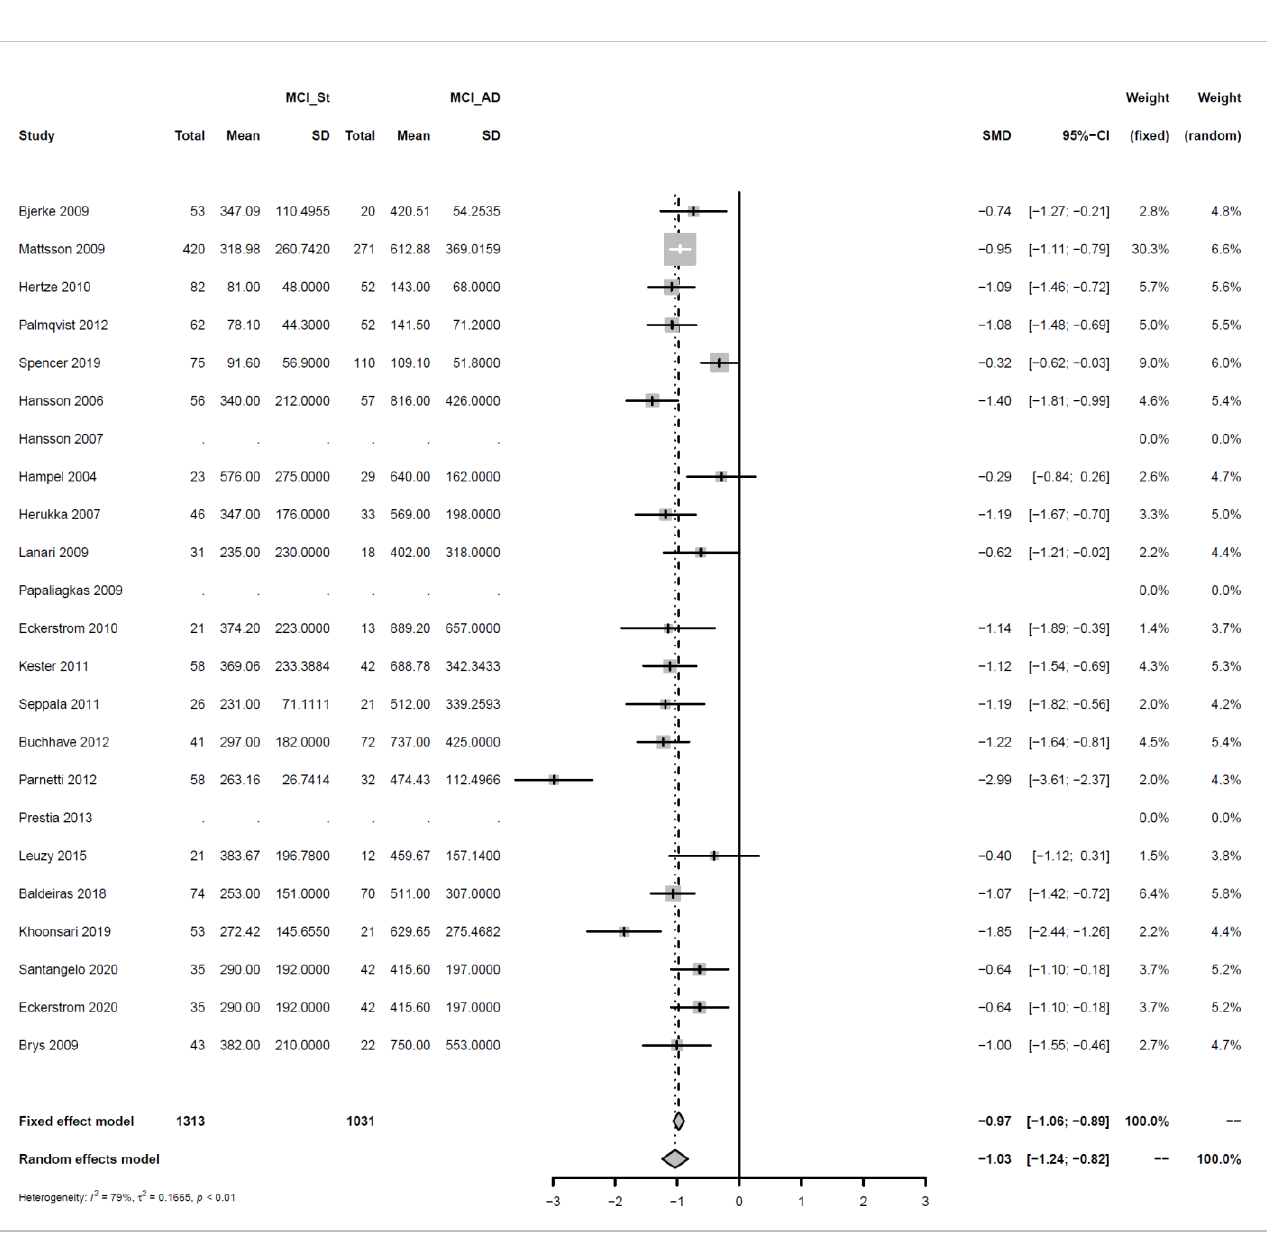
Figure 9. Meta-analysis of studies investigating CSF T-tau levels for non-progressive MCI (MCI_St) versus progressive MCI (MCI_AD), see Appendix A.3.1 [30,32,34 – 37,44 – 50,52 – 55,57,58].